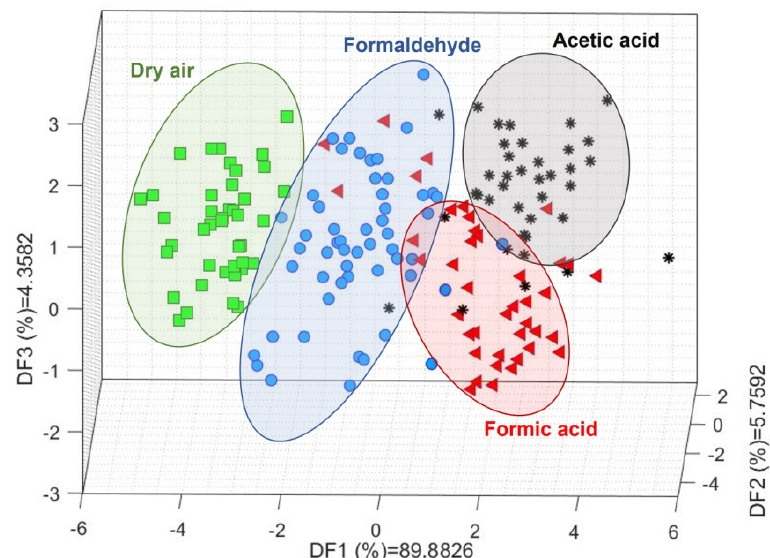
Figure 4. Linear discriminant analysis results for dry air, formaldehyde, formic acid, and acetic acid. The ellipses, as well as the different colours and shapes, are a visual guide to help differentiate each gas.